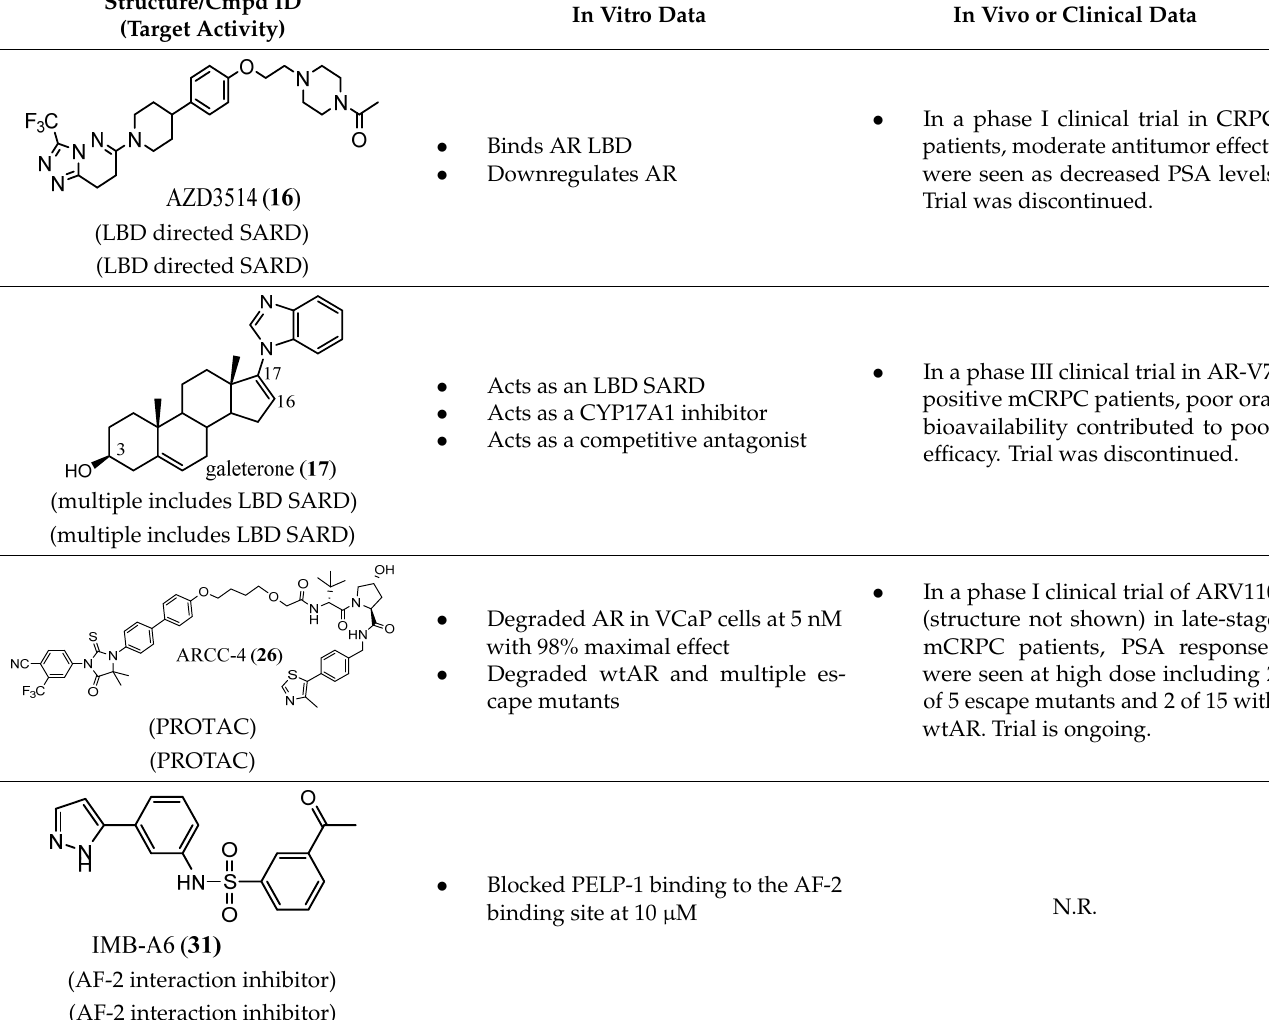
Table 1. Summary of compounds in preclinical and clinical development.